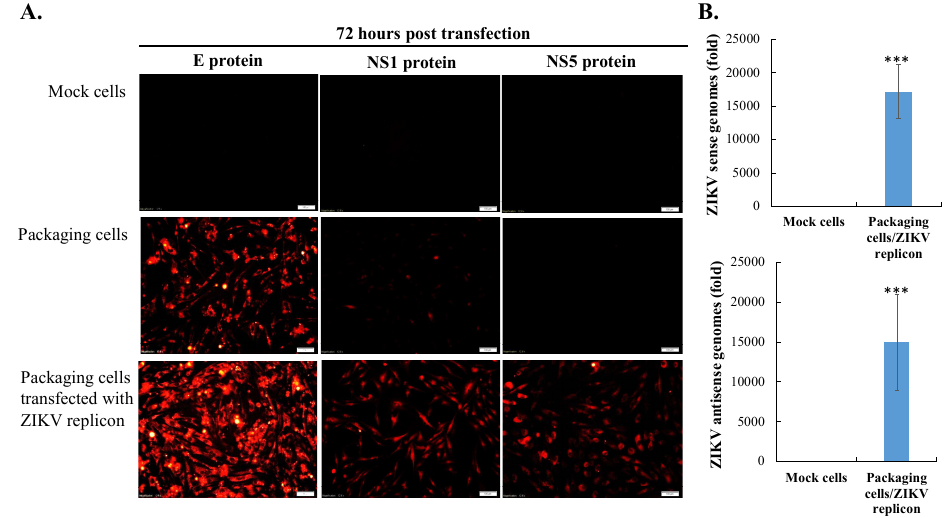
Figure 3. Analysis of viral proteins and genome synthesis in packaging cells transfected with the ZIKV Natal RGN replicon. ZIKV E, NS1, and NS5 expressions in mock cells (top), packaging cells (middle), and replicon-transfected packaging cells (bottom) were examined using the indicated primary antibodies and Alexa Fluor 546-conjugated secondary antibodies ( A ). Finally, cell imaging was conducted via immunofluorescence microscopy. In addition, relative copy numbers of sense (top) and antisense (bottom) genomes in the indicated cells were quantitated 72 h post-transfection using real-time PCR, and were then normalized to GAPDH mRNA ( B ). ***, p value < 0.001 compared with mock cells. Scale bar, 100 µ